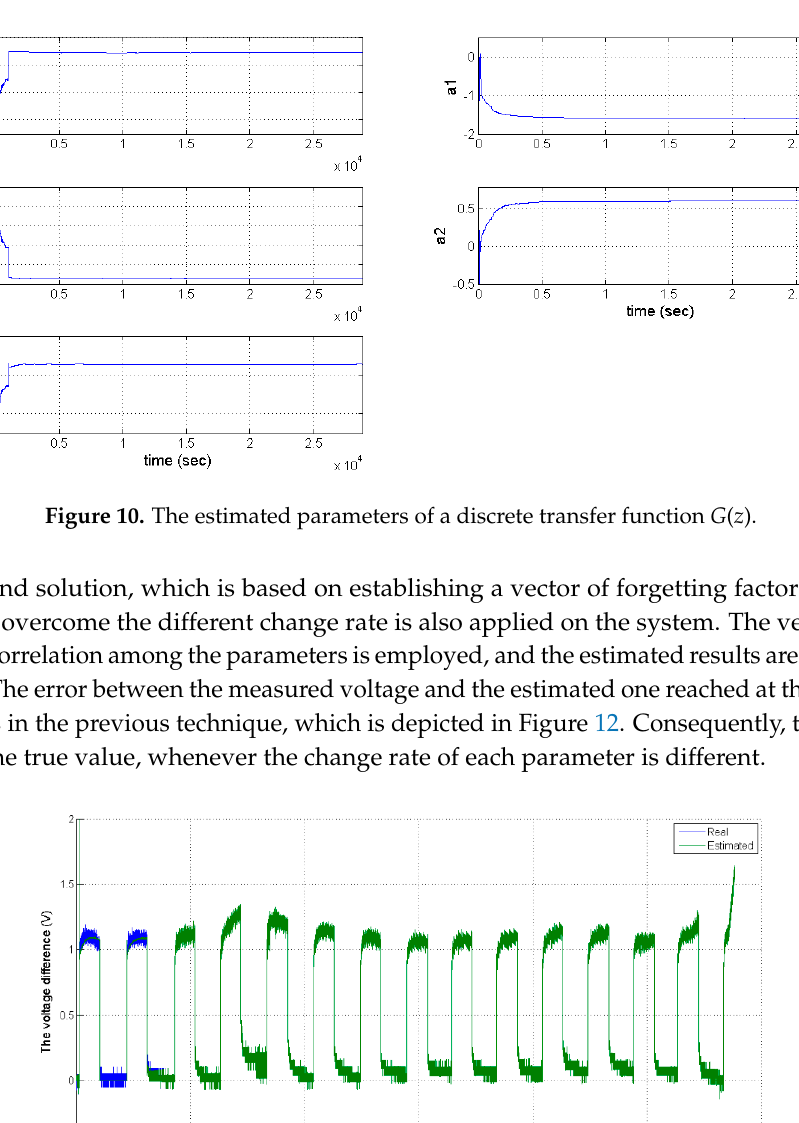
Figure 9. The error in voltage between the measured output and the estimated output.